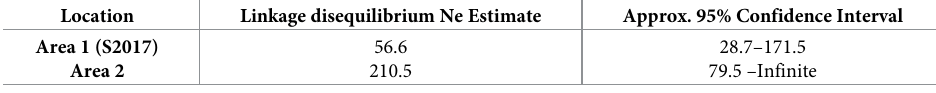
Table 4. Estimation of effective population size for all areas using linkage disequilibrium